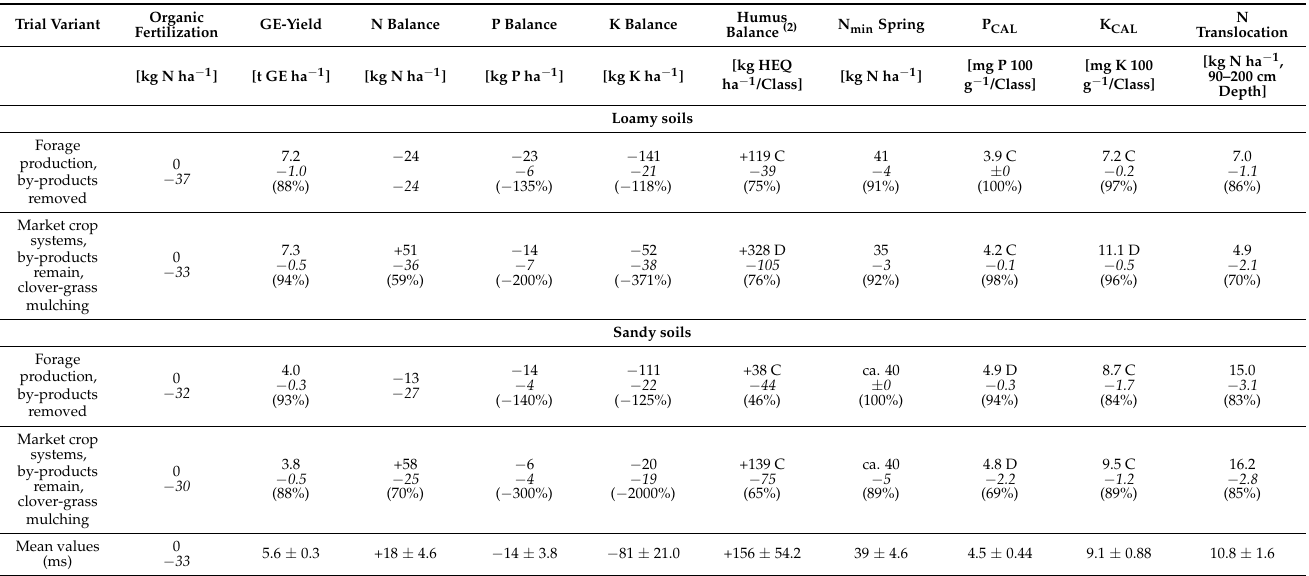
Table 3. Mean values, absolute (italics) and relative change (in parentheses) compared to a mean intensity [=100%, see Table 2], and supply classes (1) of several important characteristics of yields, nutrient balances, and soil fertility in pure forage and market crop systems without fertilization from long-term trials on loamy and sandy